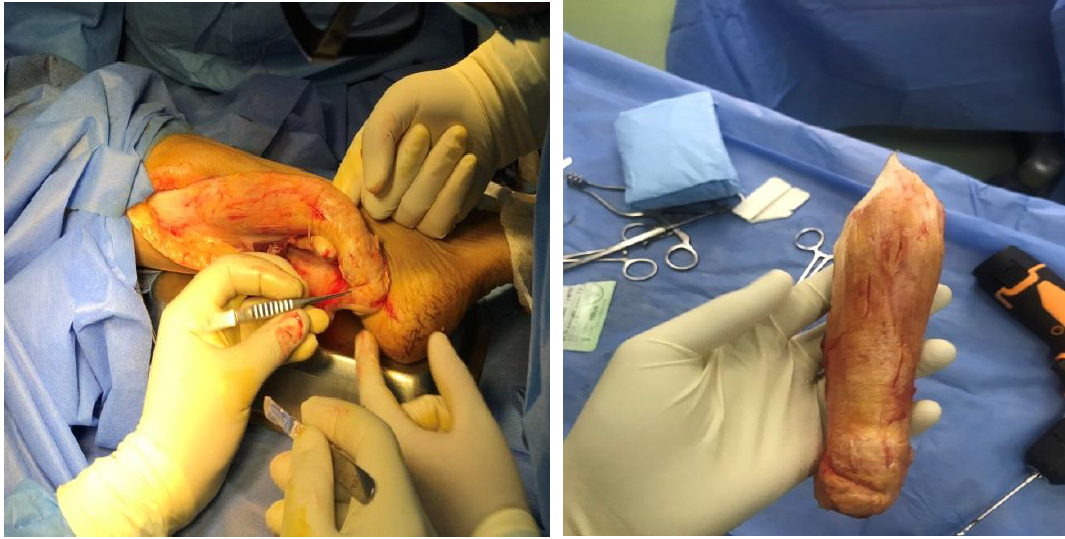
Fig 1: incision and Xanthoma before excise Fig 2: Xanthoma after excise